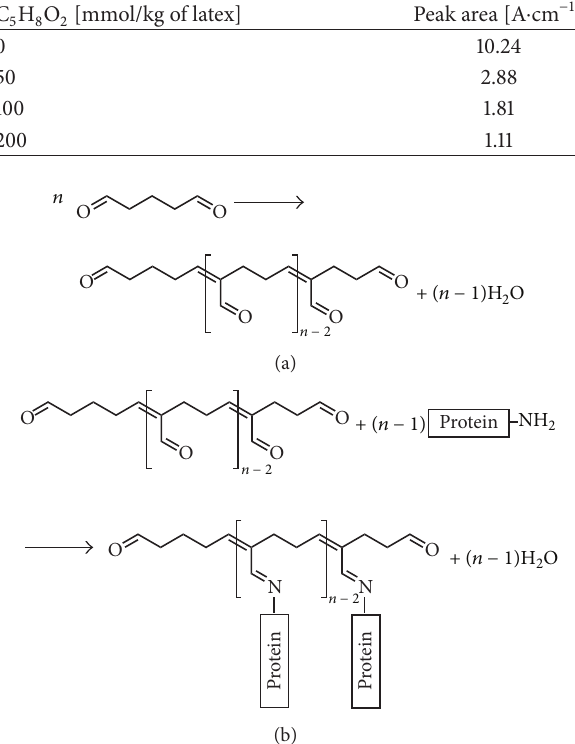
Figure 3: Proposed mechanisms for cross-linking of proteins by C 5 H 8 O 2 via Maillard reaction [9],